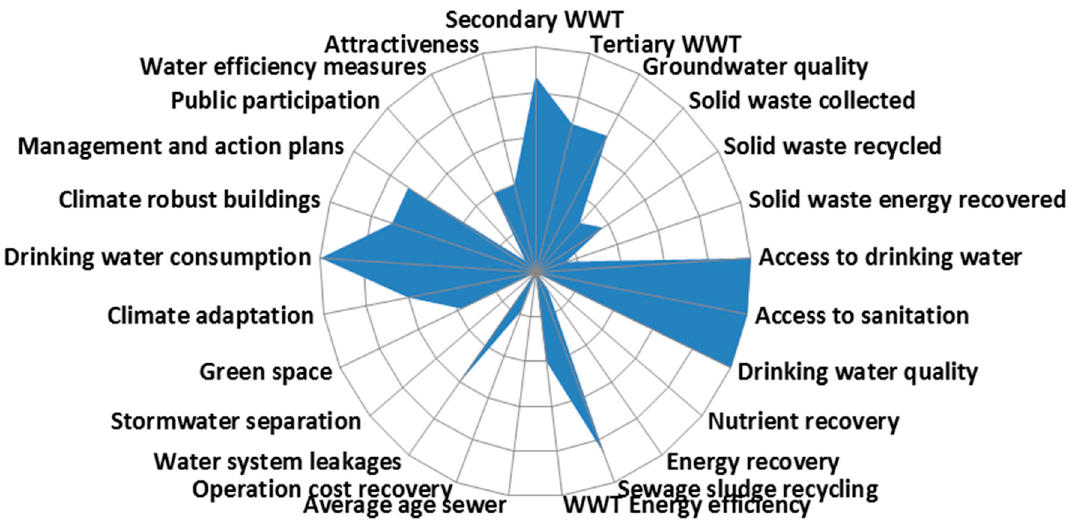
Figure 1. Spiderweb of the City Blueprint analysis of the city of Sabadell, Spain. The scores range from 0 (poor performance; centre of the circle) to 10 (high performance; periphery of the circle). The results are reported in detail in the study by Šteflová [30].